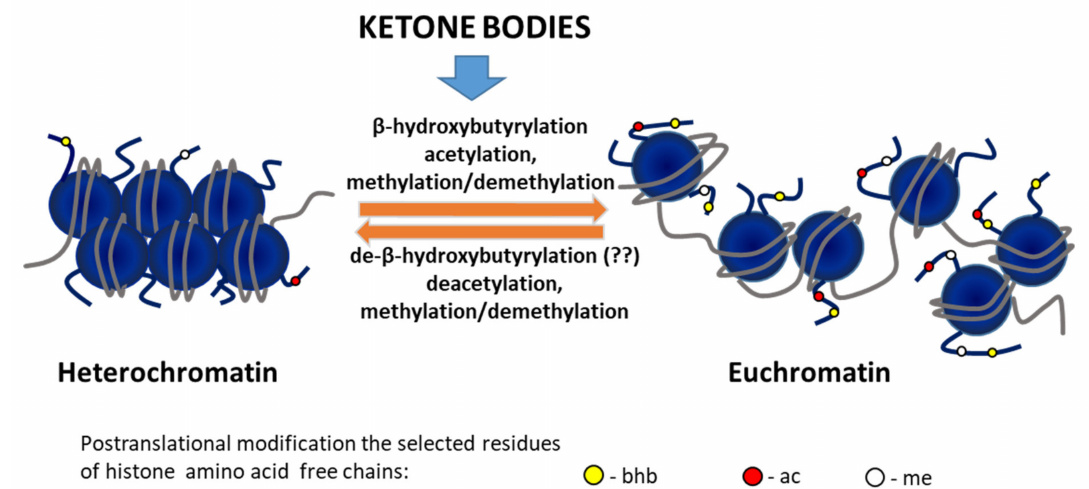
Figure 2. The epigenetic e ff ect of ketone bodies on chromatin status. Pathways of modification of chromatin conformation by ketone bodies through histone posttranslational modifications (PTMs): (i) increasing the pool of acetyl-CoA as substrate for HATs, (ii) inducing changes methylation status